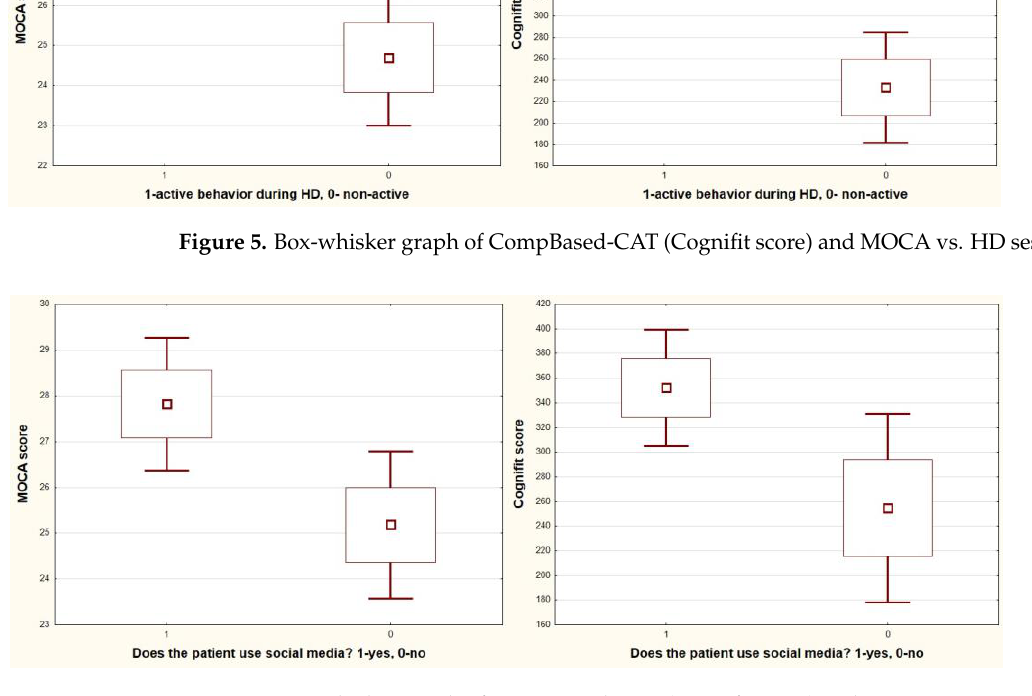
Figure 6. Box-whisker graph of CompBased-CAT (Cognifit score) and MOCA vs. using social media.